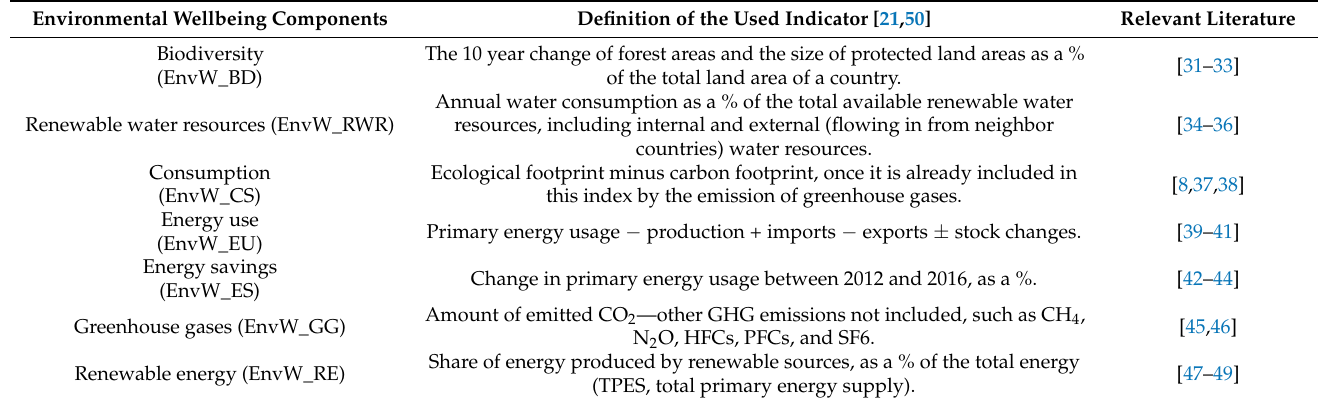
Table 1. Definition of environmental wellbeing’s components.